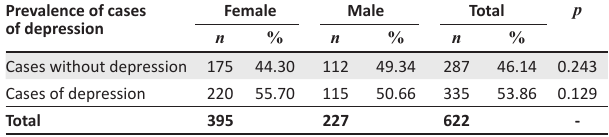
TABLE 3: Prevalence of cases of depression with gender ratios.